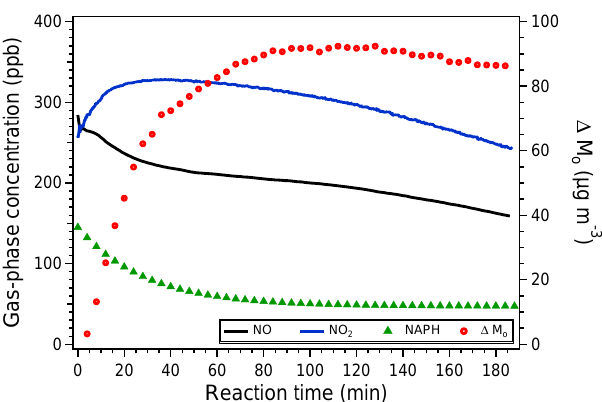
Figure 1. Typical reaction profile for a chamber experiment un- der RO 2 + NO-dominant conditions. NO and NO 2 concentrations were monitored by CAPS NO 2 and chemiluminescence NO x mon- itors, respectively. Hydrocarbon decay was monitored using GC- FID, while initial hydrocarbon (naphthalene) concentrations were determined using the chamber volume and mass of hydrocarbon in- jected. Aerosol mass concentrations were determined using volume concentrations obtained from SMPS and assuming an aerosol den- sity of 1gcm − 3 . While typical SOA density is about 1.4gcm − 3 , it varies with hydrocarbon precursor identity and reaction condi- tions, and a density between ∼ 1.0 and 1.6gcm − 3 has been re- ported in previous studies (Ng et al., 2006, 2007a, b; Chan et al., 2009; Tasoglou and Pandis, 2015; Bahreini et al., 2005). The use of a density of 1gcm − 3 is to facilitate easier comparisons with past and future studies. Results from future studies can be scaled accord- ingly for comparison with the current work. Mass concentrations have been corrected for particle wall loss (Nah et al.,